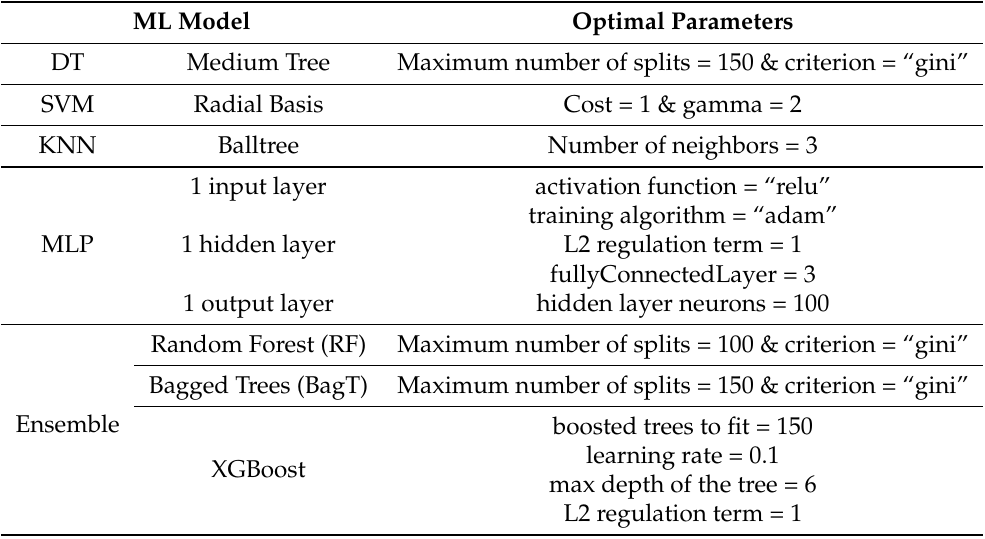
Table 2. Used classical machine-learning classifiers and optimal